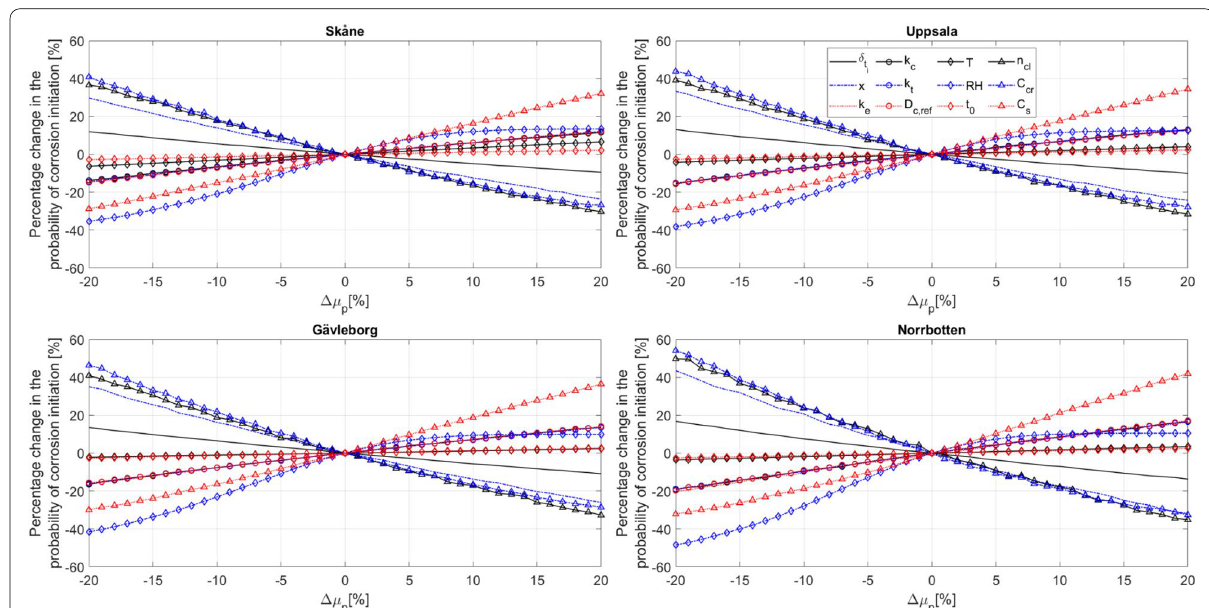
Fig. 10 Percentage change in the end-of-century probability of corrosion initiation due to changes in the mean value of the different input parameters in the corrosion initiation model considering the historical climate (1961–1990)